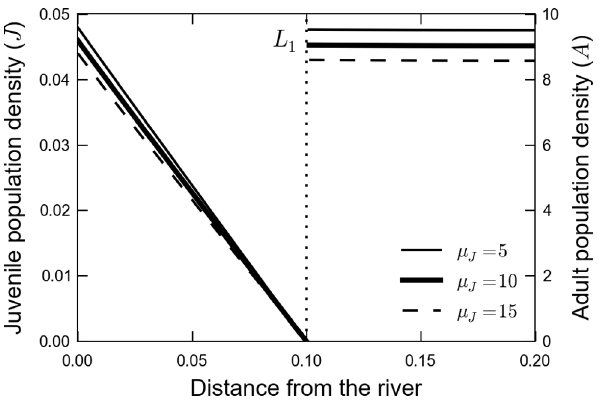
Figure 2. Stationary solutions of the model as a function of space. In the model, all distances are measured according to the reproductive site that is taken as zero. The fragment starts at L 1 and ends at L 2 . Each curve refers to a given juvenile mortality in the matrix ( m J ). The parameters used were r ~ K ~ m J ~ D J ~ D A ~ 1 , b ~ 0 and m